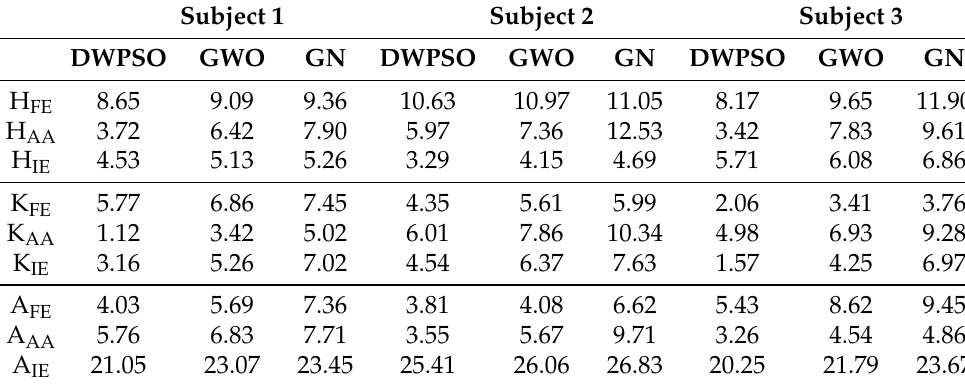
Table 2. The RMSE ( ◦ ) comparison of three algorithms when IMUs on three subjects were bound in position